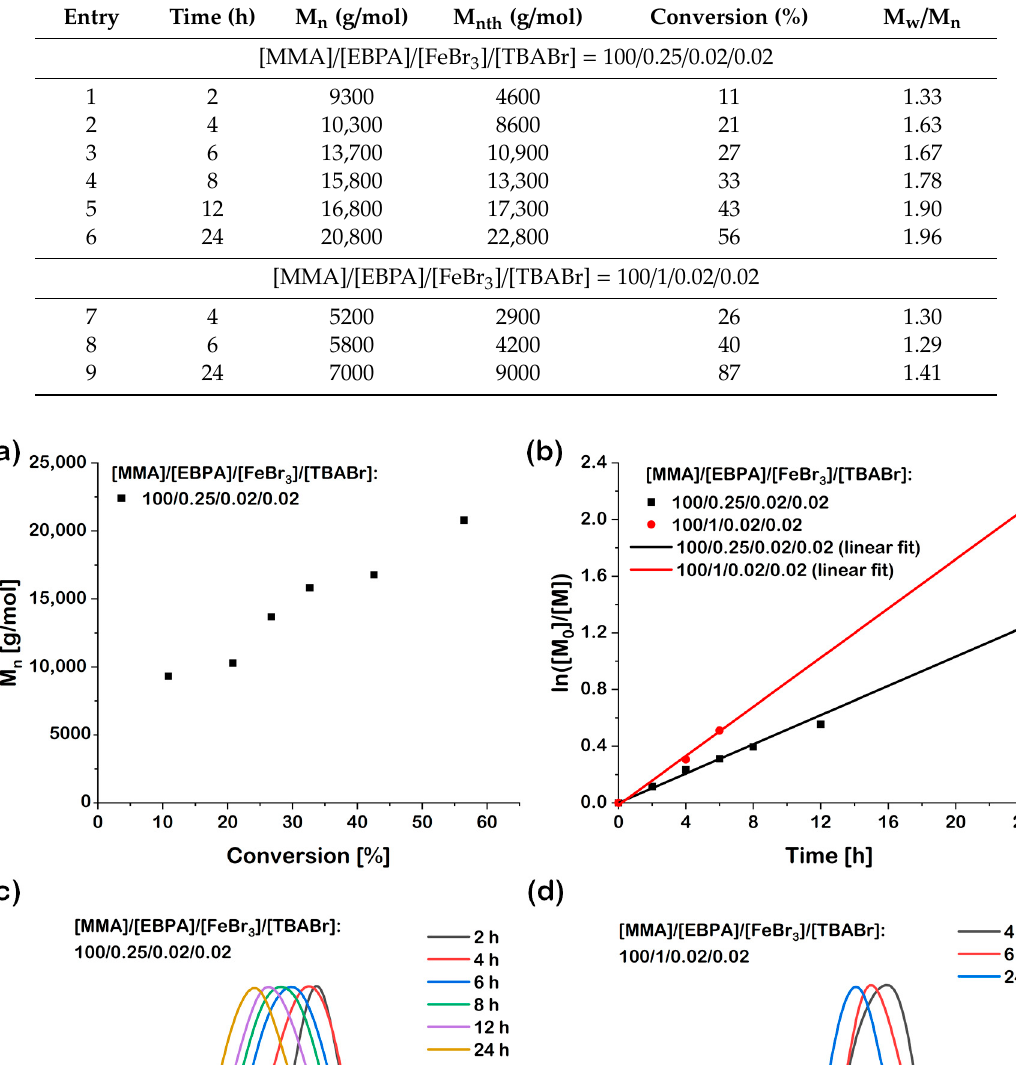
Table 2. Results of syntheses of PMMA polymers in the solution by photo-Fe-ATRP.